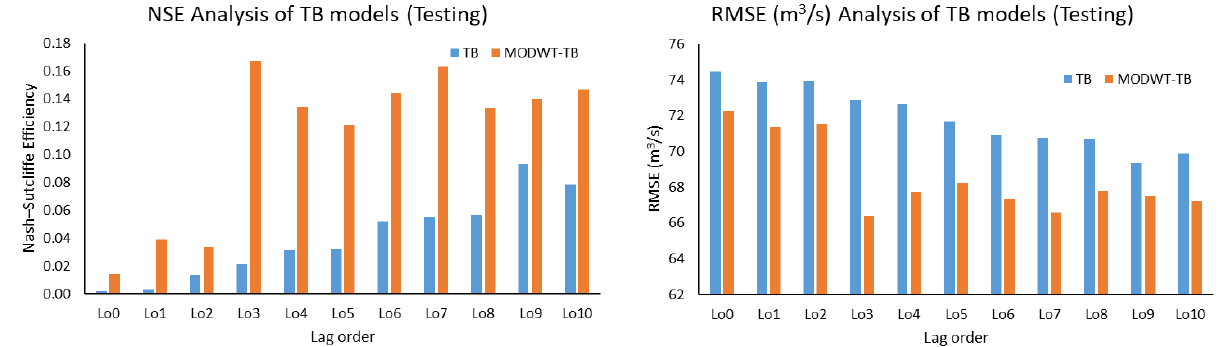
Figure 10. Performance evaluation of the TB and MODWT-TB models.